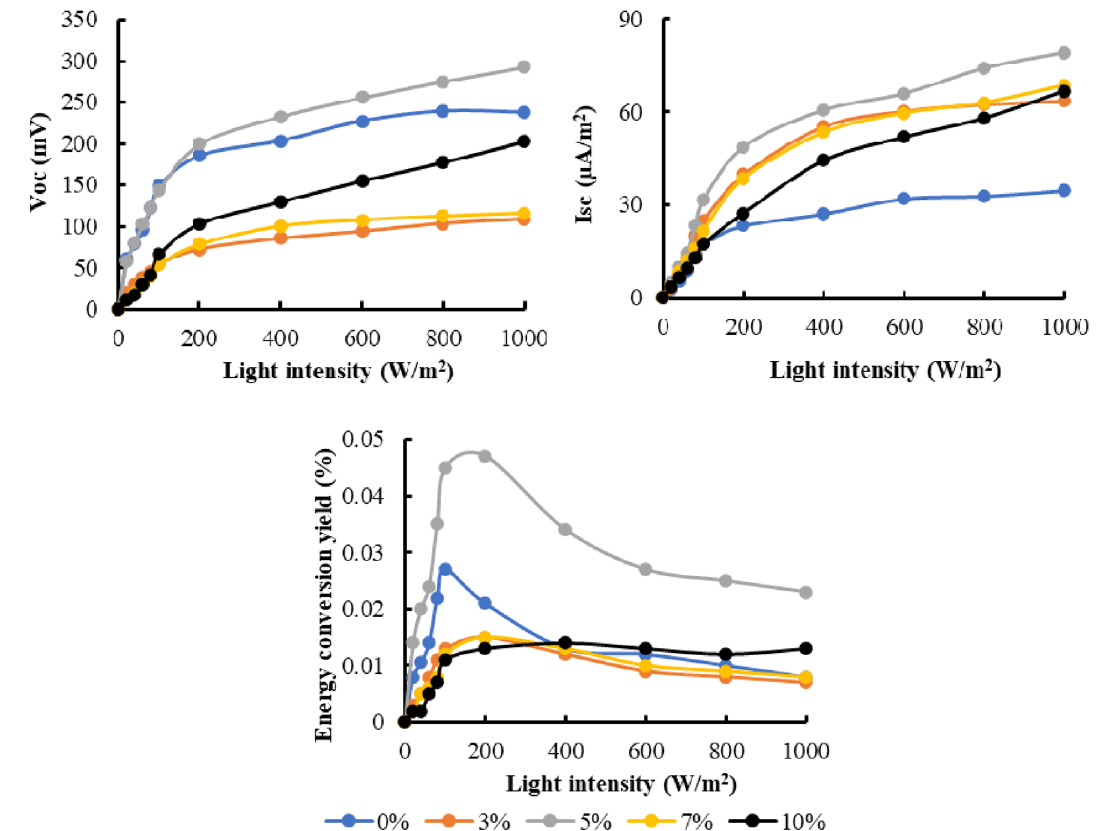
Fig. 5 Parameters affecting DSSCs performance using TiO 2 /TMK-based photoelectrodes with different concentrations of